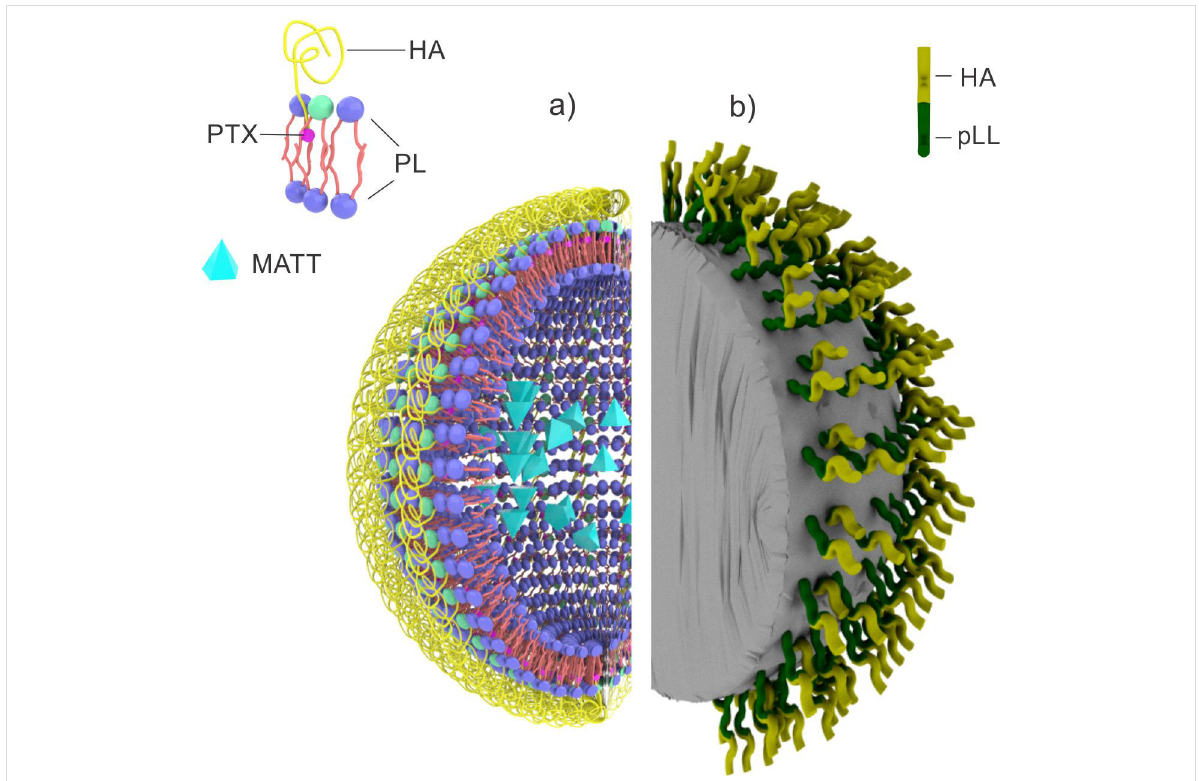
Figure 6: HA-functionalized NDDS with multimodal targeting capabilities. (a) HA–paclitaxel (PTX) complex and marimastat (MATT)-loaded liposomes providing dual action after thermally induced disassembly of the formulation. MATT stabilizes the tissue microenvironment by inhibiting MMPs, while HA promotes CD44-mediated uptake of PTX (PL: phospholipids); adapted from [174]. (b) HA–poly( ʟ -lysine) (pLL) layer-by-layer polystyrene nanopar- ticles with dual targeting capability based on hypoxia-induced surface polarity shift and HA–CD44 specific affinity; adapted from [185].